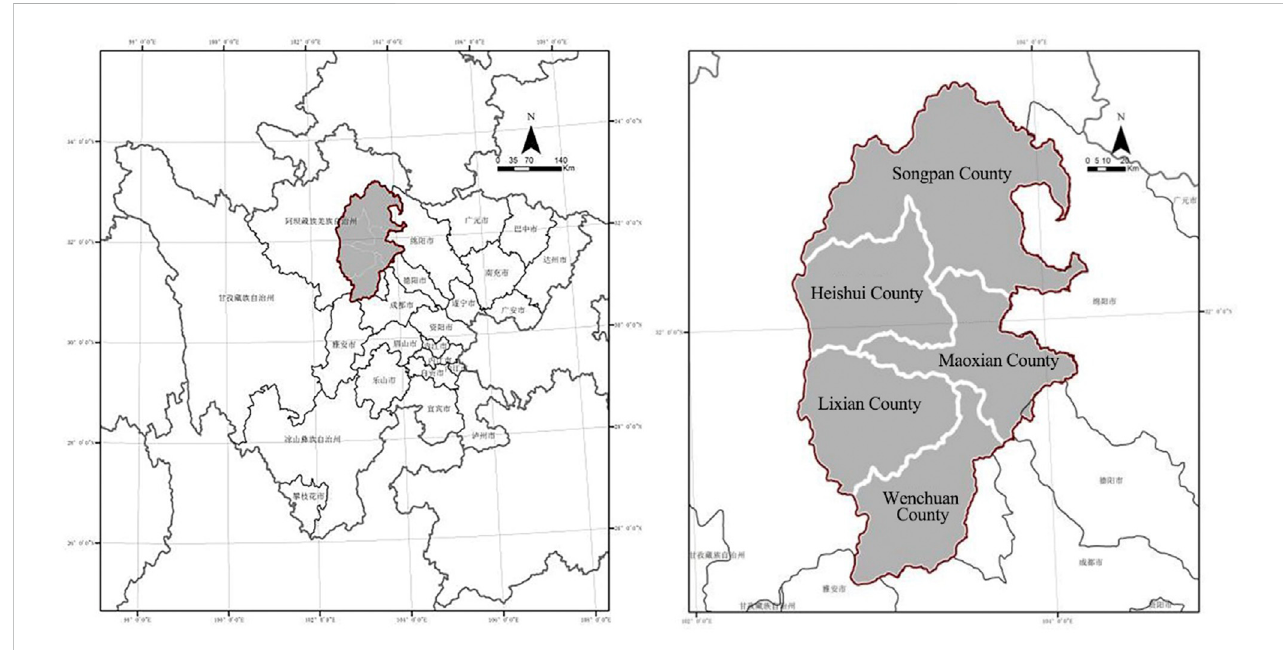
FIGURE 1 The location of core regions in Minjiang wateshed (Source: Author